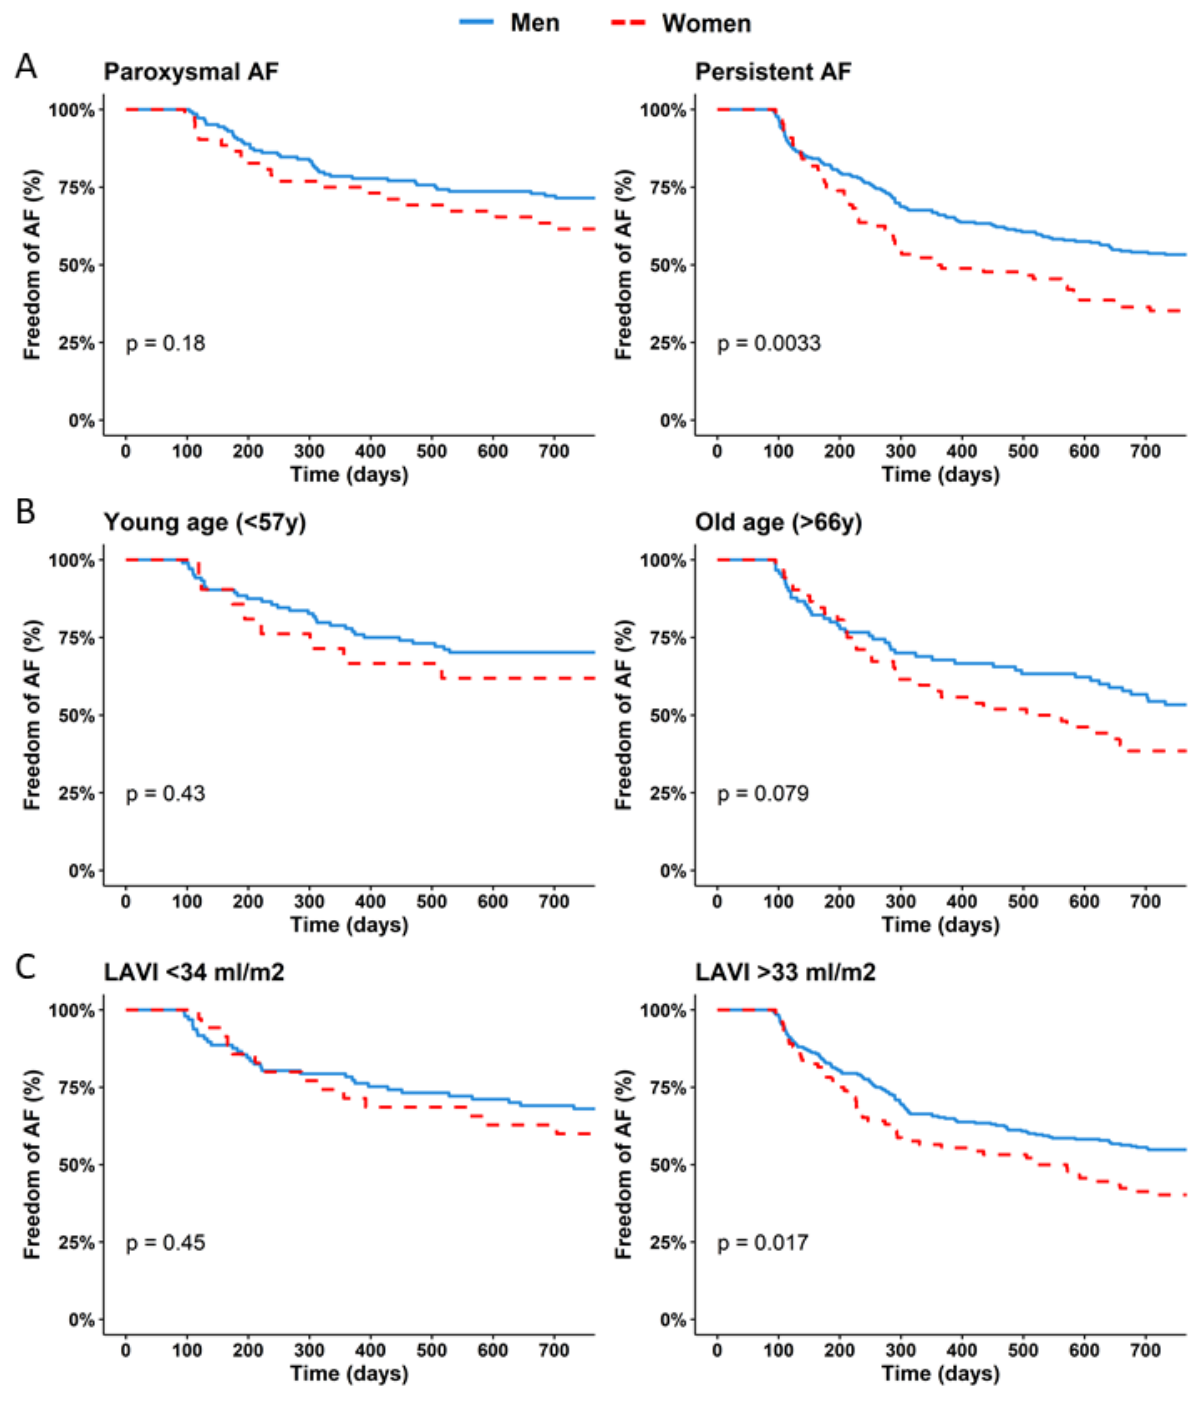
Figure 4. Different impact of the risk factors between women and men. ( A ) Patients with paroxysmal AF (left) and persistent AF (right); ( B ) young (first quartile, <55 y) and old patients (fourth quartile, >67 y); ( C ) normal LA size (LAVI < 34 mL/m 2 ) and enlarged LA (LAVI > 33mL/m 2 ).